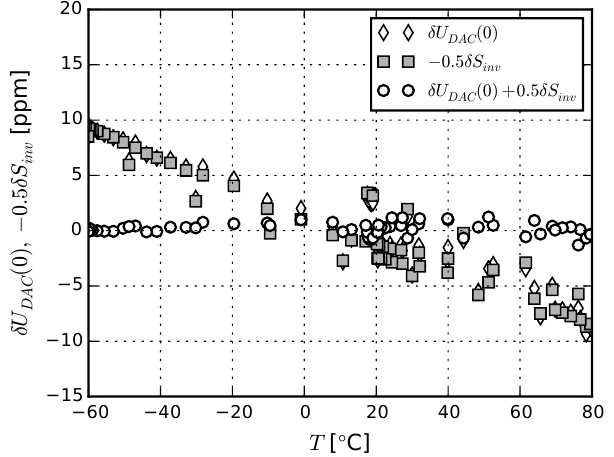
Figure 8. Temperature drift of the voltage-to-current converter transformation factor.